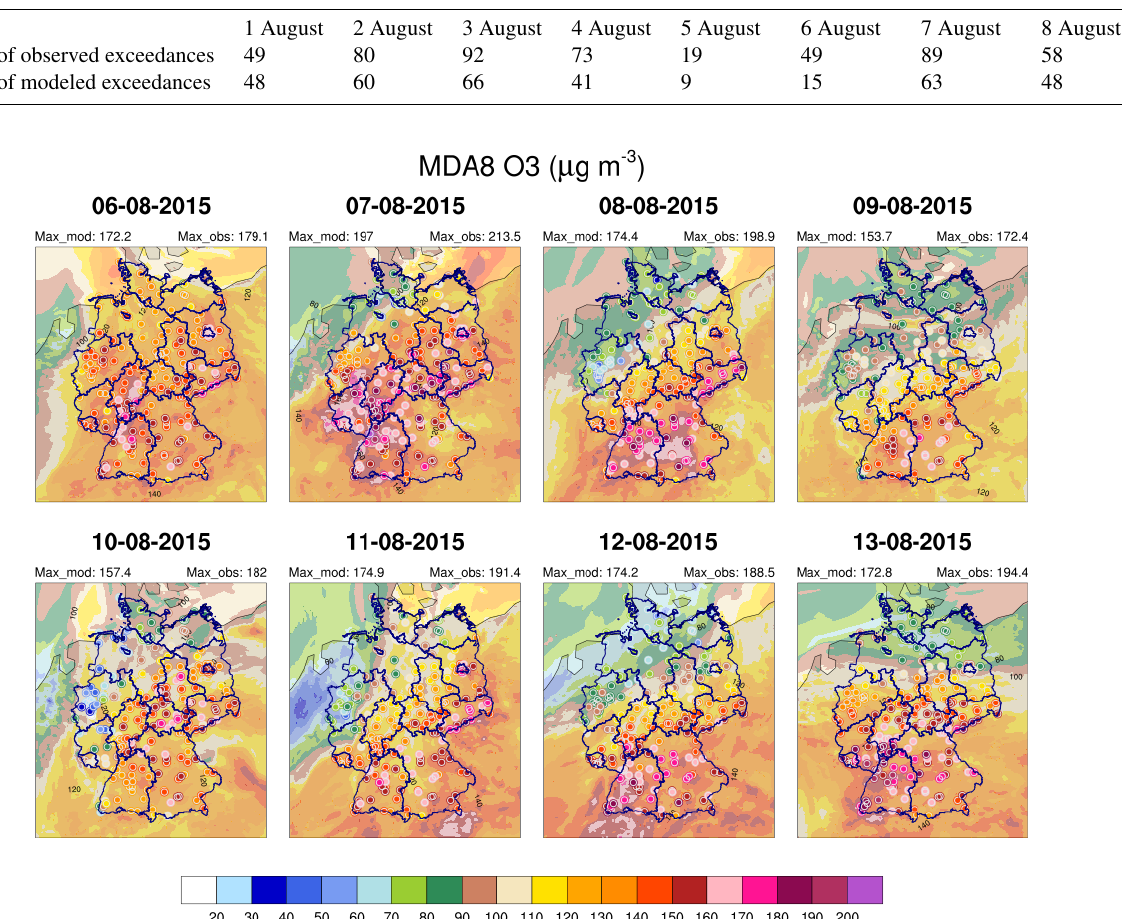
Figure 2. Daily surface MDA8 O 3 (µgm − 3 ) for the 6–13 August 2015 period. Colored dots represent the observed MDA8 O 3 concentrations at the German background